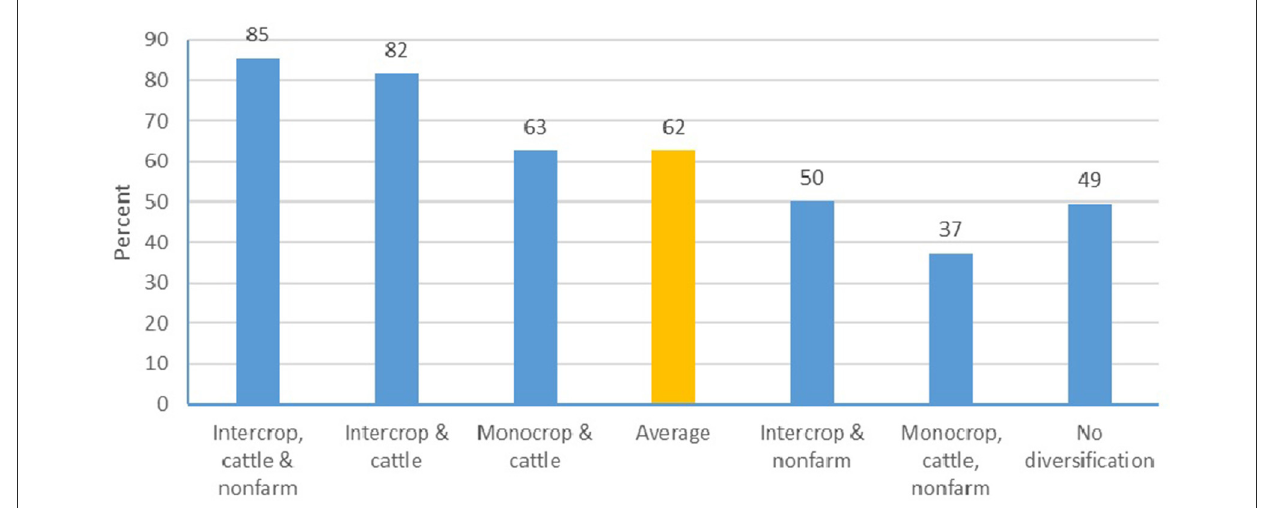
FIGURE5 Reported shock, but no significant impact on